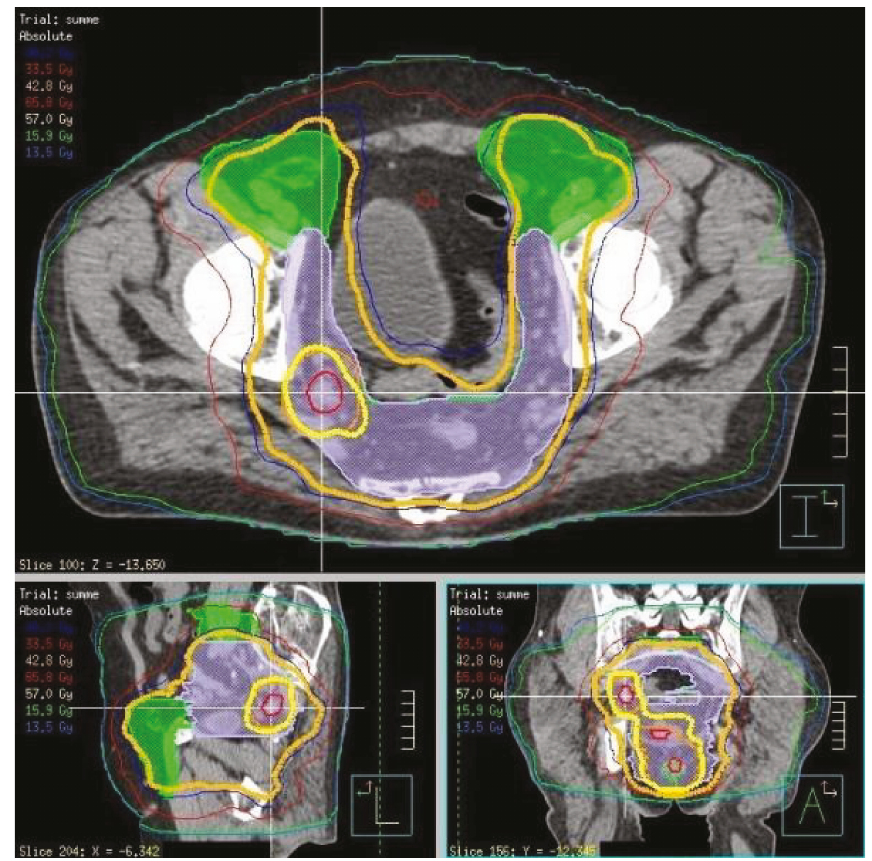
Figure 2: Dose distribution in the sum plan at the level of the right internal iliac lymph node